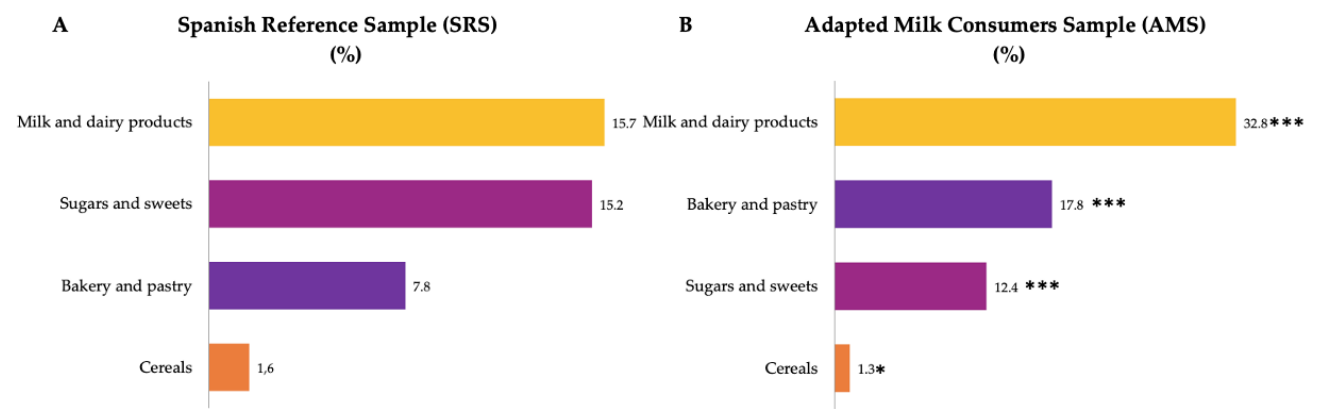
Figure 3. Dietary food and beverage groups contributing to added sugar intakes (%) from the EsNuPI study population (“Spanish Pediatric Population”) in both the Spanish Reference Sample ( A ) and the Adapted Milk Consumers Sample ( B ). * p ≤ 0.05 compared to reference sample (Mann–Whitney test); *** p ≤ 0.001 compared to reference sample (Mann–Whitney test). Only foods contributing ≥ 1% to total added sugar intakes of the population have been included.